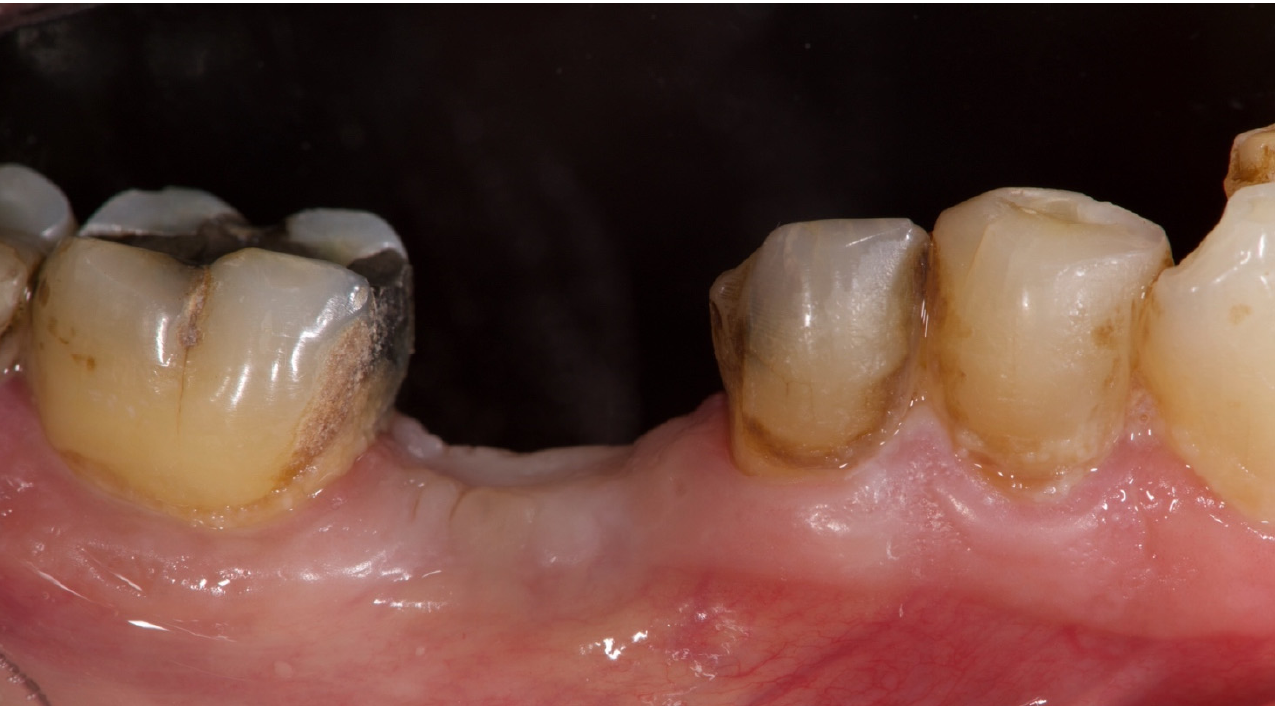
Figure 8. Lateral view four months after tooth extraction and socket preservation procedure.